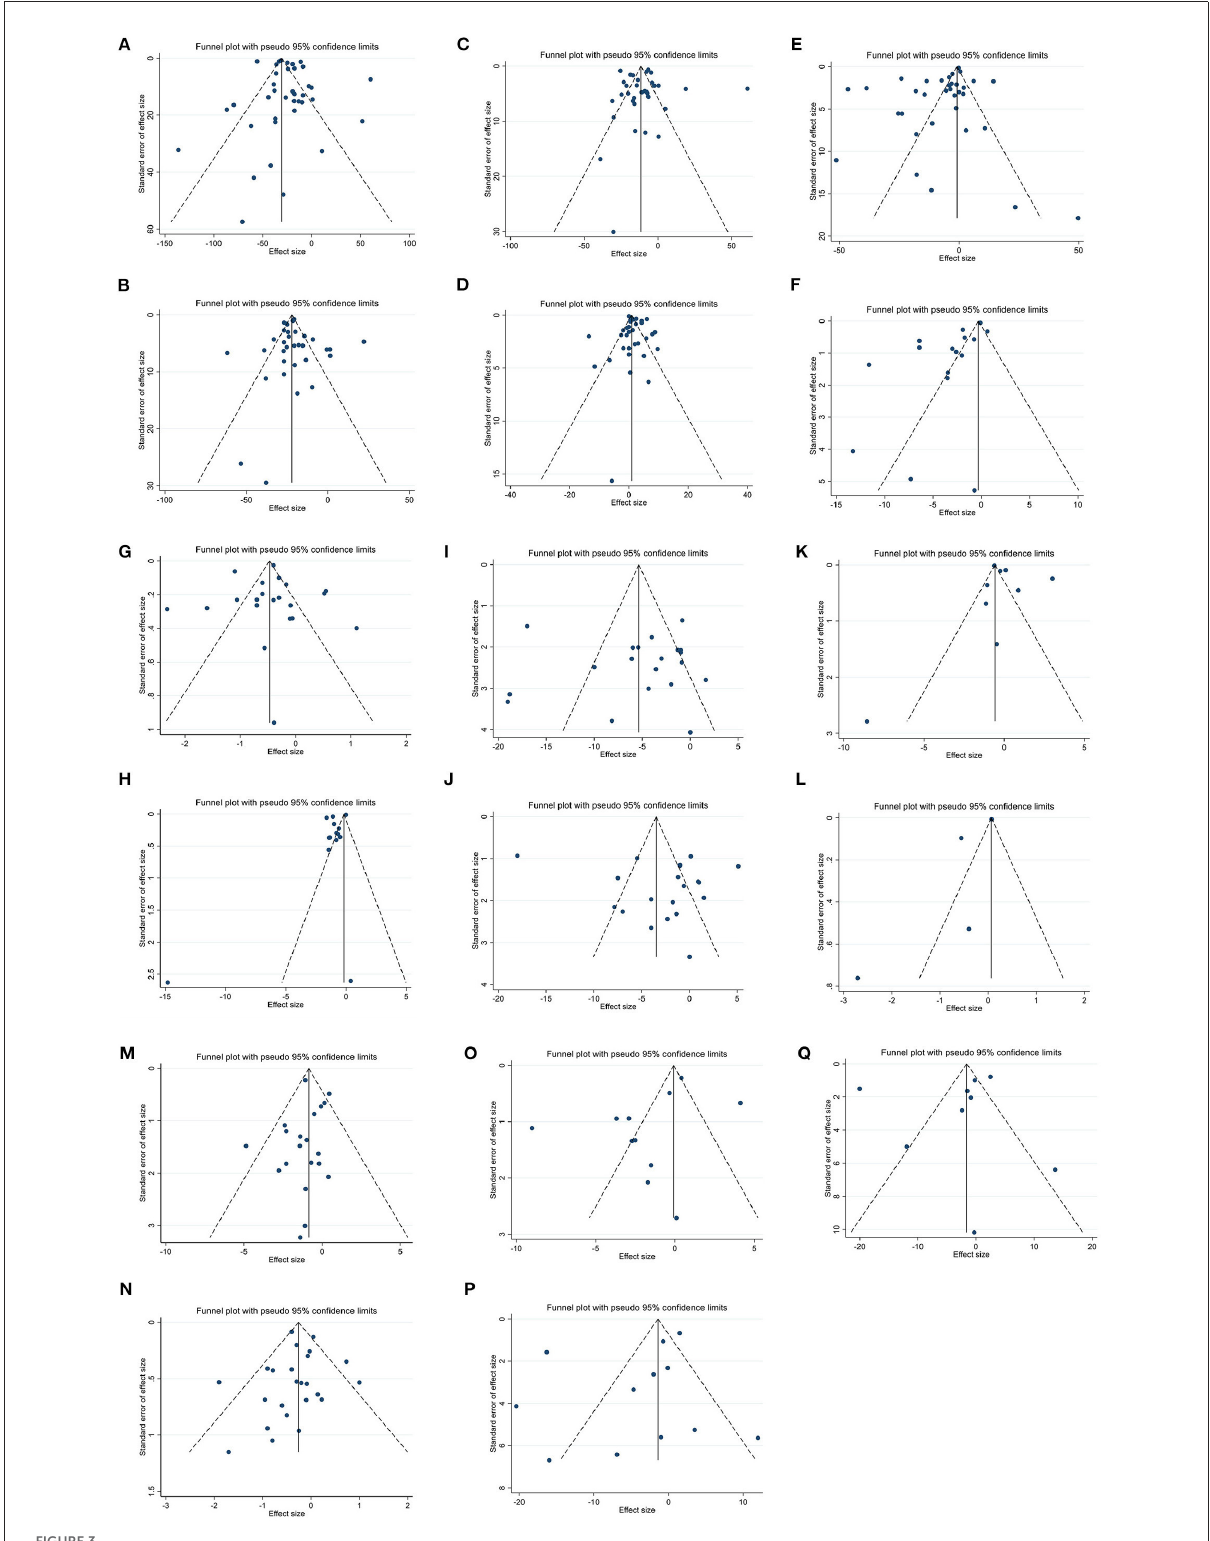
FIGURE3 Funnel plots for the effect of berberine consumption on (A) TG (mg/dl); (B) TC (mg/dl); (C) LDL (mg/dl); (D) HDL (mg/dl); (E) FBG (mg/dl); (F) Insulin (mg/dl); (G) HbA1c (%); (H) HOMA-IR; (I) SBP (mmHg); (J) DBP (mmHg); (K) CRP (mg/L); (L) IL-6 (ng/L); (M) weight (kg); (N) BMI (kg/m 2 ); (O) WC (cm); (P) ALT (U/L); and (Q) AST (U/L). TG, triglyceride; TC, total cholesterol; LDL, low-density lipoprotein; HDL, high-density lipoprotein; FBG, fasting blood glucose; HOMA-IR, homeostasis model assessment for insulin resistance; hemoglobin A1c, HbA1c; CRP, C-reactive protein; IL-6, interleukin 6; WC, waist circumference; ALT, alanine transaminase; AST, aspartate transaminase; SBP, systolic blood pressure; DBP, diastolic blood pressure; CI, confidence interval, weighted mean difference;